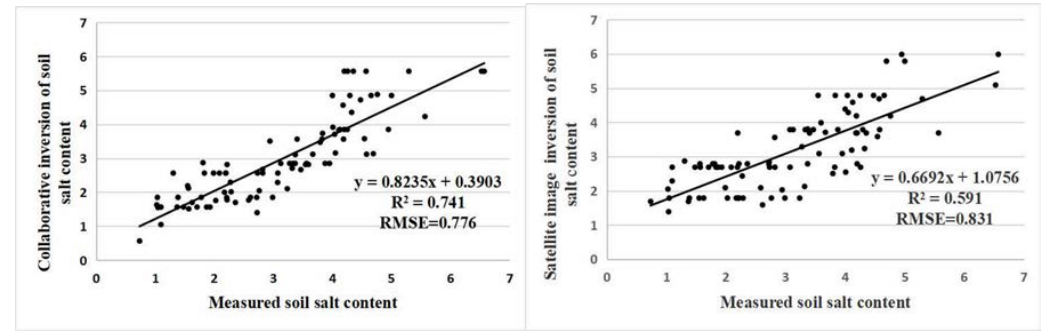
Figure 8. Scatter plots of measured sample points and soil salinity inversion results by two methods in Kenli District.